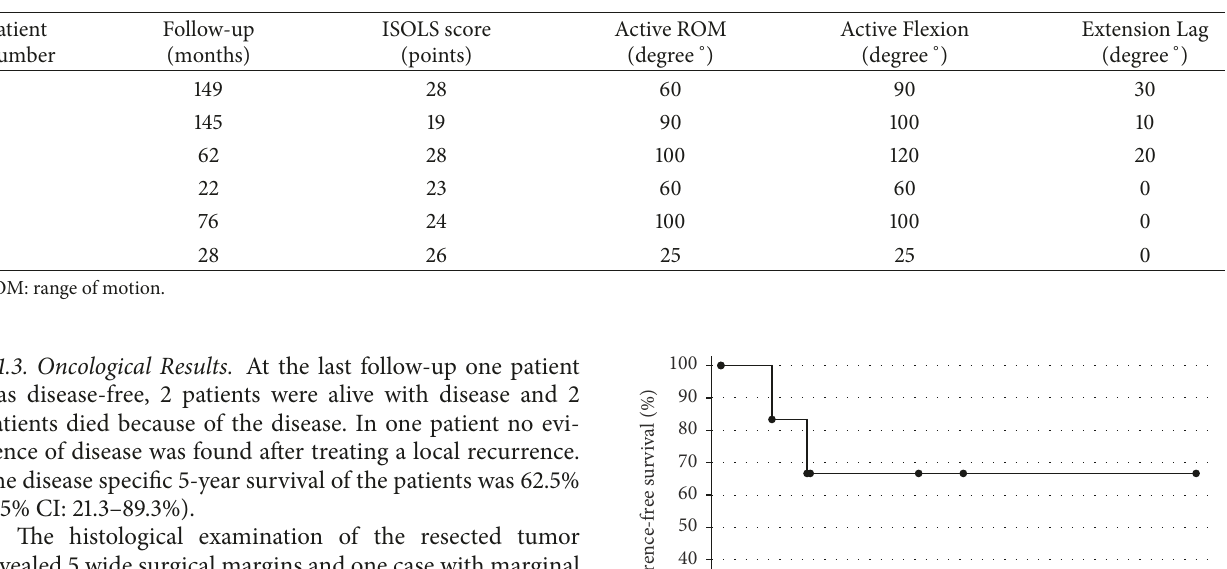
Table 3: Functional results.